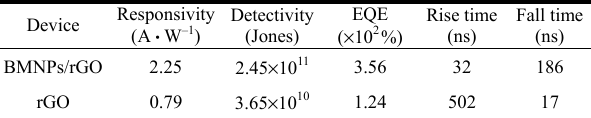
Table 1 Comparison of performance device between the rGO and bimetallic